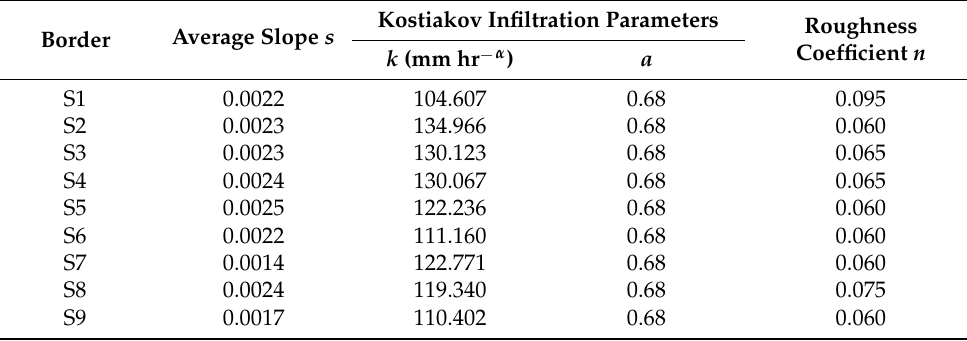
Table 1. Input parameters of each border for surface irrigation.